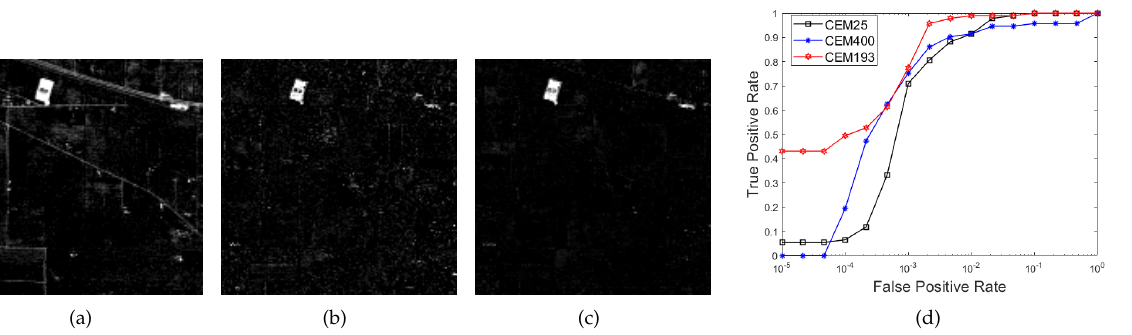
Figure 10. For the Indian Pines data, ( a ): the CEM result with 25 bands via down-sampling by averaging the data with 200 bands; ( b ): the CEM result with 400 bands generated by GCEM; ( c ): the CEM result for the data with the skewness selection process, and L = 193; ( d ): the ROC curves with different L s.